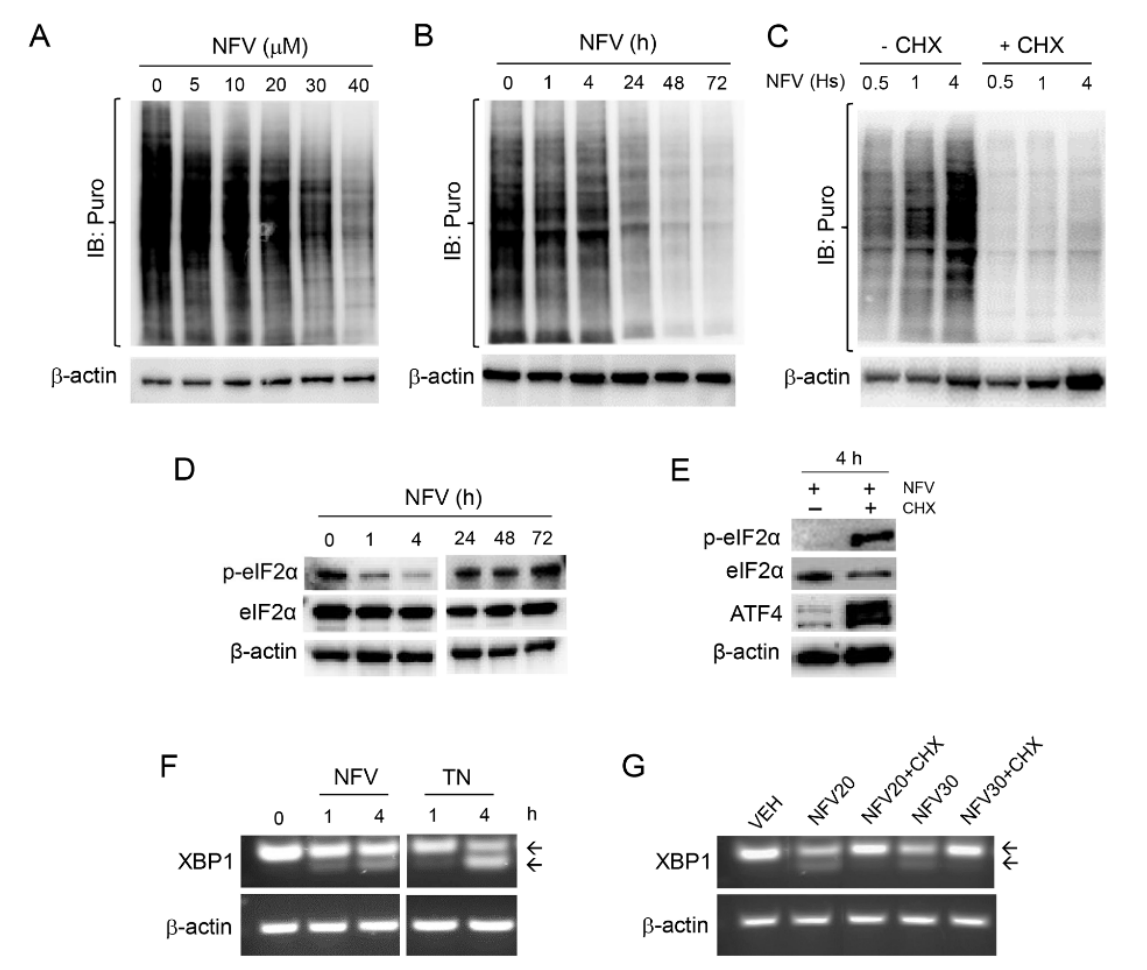
Figure 4. NFV, in a concentration- ( A ) and time-dependent manner ( B ), triggers a decrease in the incorporation of puromycin (Puro) into newly synthesized peptides. ( C ) The incorporation of Puro is sustained in the presence of 20 µM NFV during the first 4 h of treatment, but it is abrogated by the simultaneous presence 10 µg/mL of the protein synthesis inhibitor cycloheximide (CHX). ( D ) Effect of 20 µM NFV on the phosphorylation of eIF2 α on Serine 51 (p-eIF2 α ) along a 72 h incubation period. ( E ) A short-term (4 h) treatment with 20 µM NFV associates with low expression of p-eIF2 α and downstream transcription factor ATF4, yet both p-eIF2 α and ATF4 radically increase with the simultaneous presence of CHX (10 µg/mL). ( F ) Effect of 20 µM NFV on the splicing of XBP1 mRNA assessed by RT-PCR; TN, tunicamycin (2 µg/mL). Arrows indicate total and spliced XBP1 mRNA variants. ( G ) Splicing of XPB1 mRNA in cells co-incubated for 4 h with NFV and CHX (10 µg/mL); NFV20, 20 µM; NFV30, 30 µM. All results presented were performed in PEO1 cells and are repre- sentative of two experiments that had a similar outcome. Reduction in global protein synthesis upon ER stress induction occurs because of the phosphorylation of eIF2 α . This is a polypeptide chain translation initiator factor that limits protein synthesis under conditions of cellular stress based on its capacity to become phosphorylated on serine 51 [46], thus limiting the availability of eIF2 α needed for translation initiation [47]. The basal levels of eIF2 α phosphorylation on serine 51